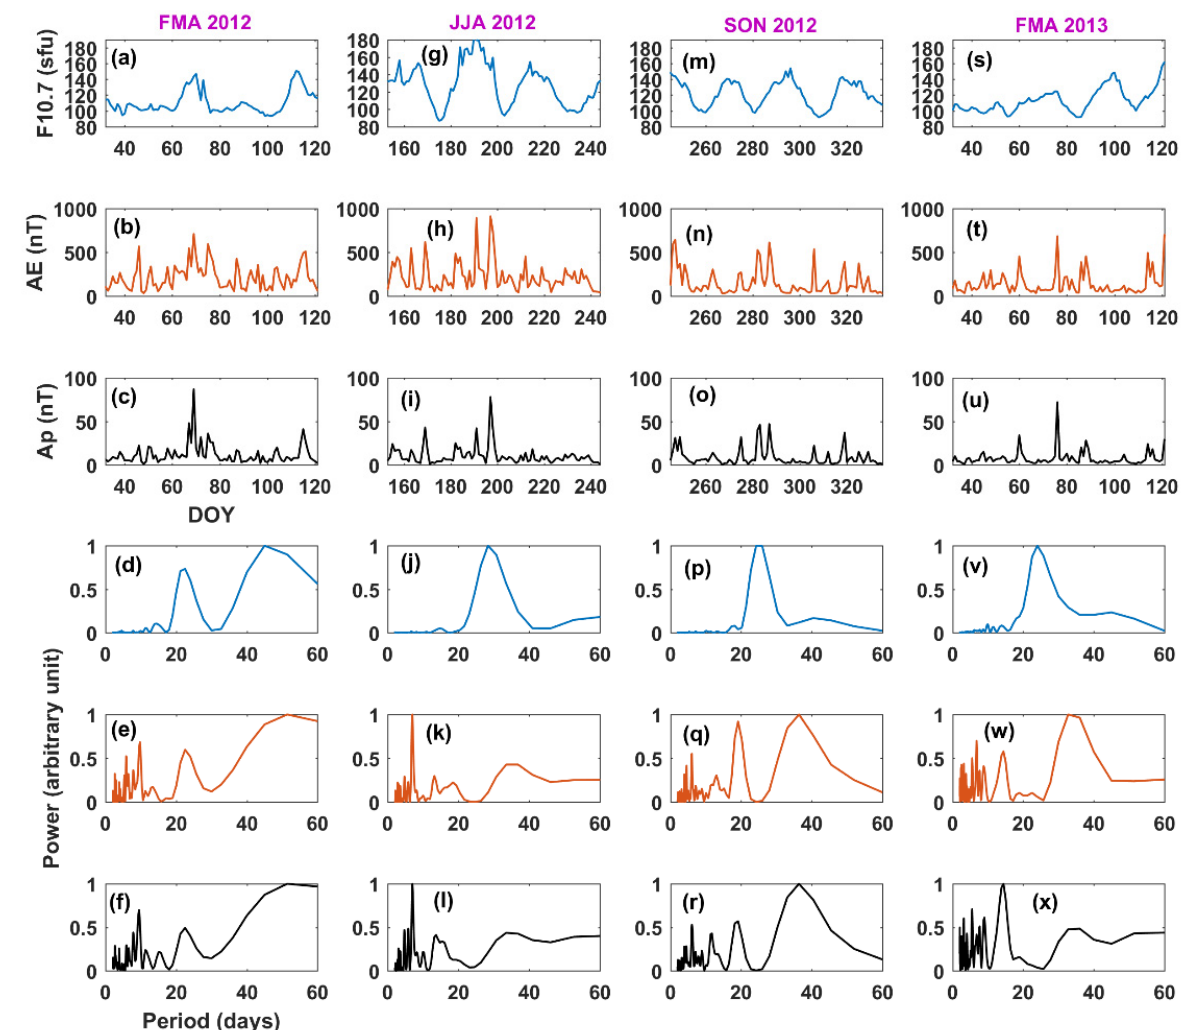
Figure 5. Lomb–Scargle spectra of geomagnetic and solar irradiance proxies. ( a – c ) present daily average F10.7, AE, and Ap, respectively, during the vernal equinox period in 2012. ( d – f ) presents the Lomb–Scargle spectrum of F10.7, AE, and Ap, respectively, derived from the DOY series shown in